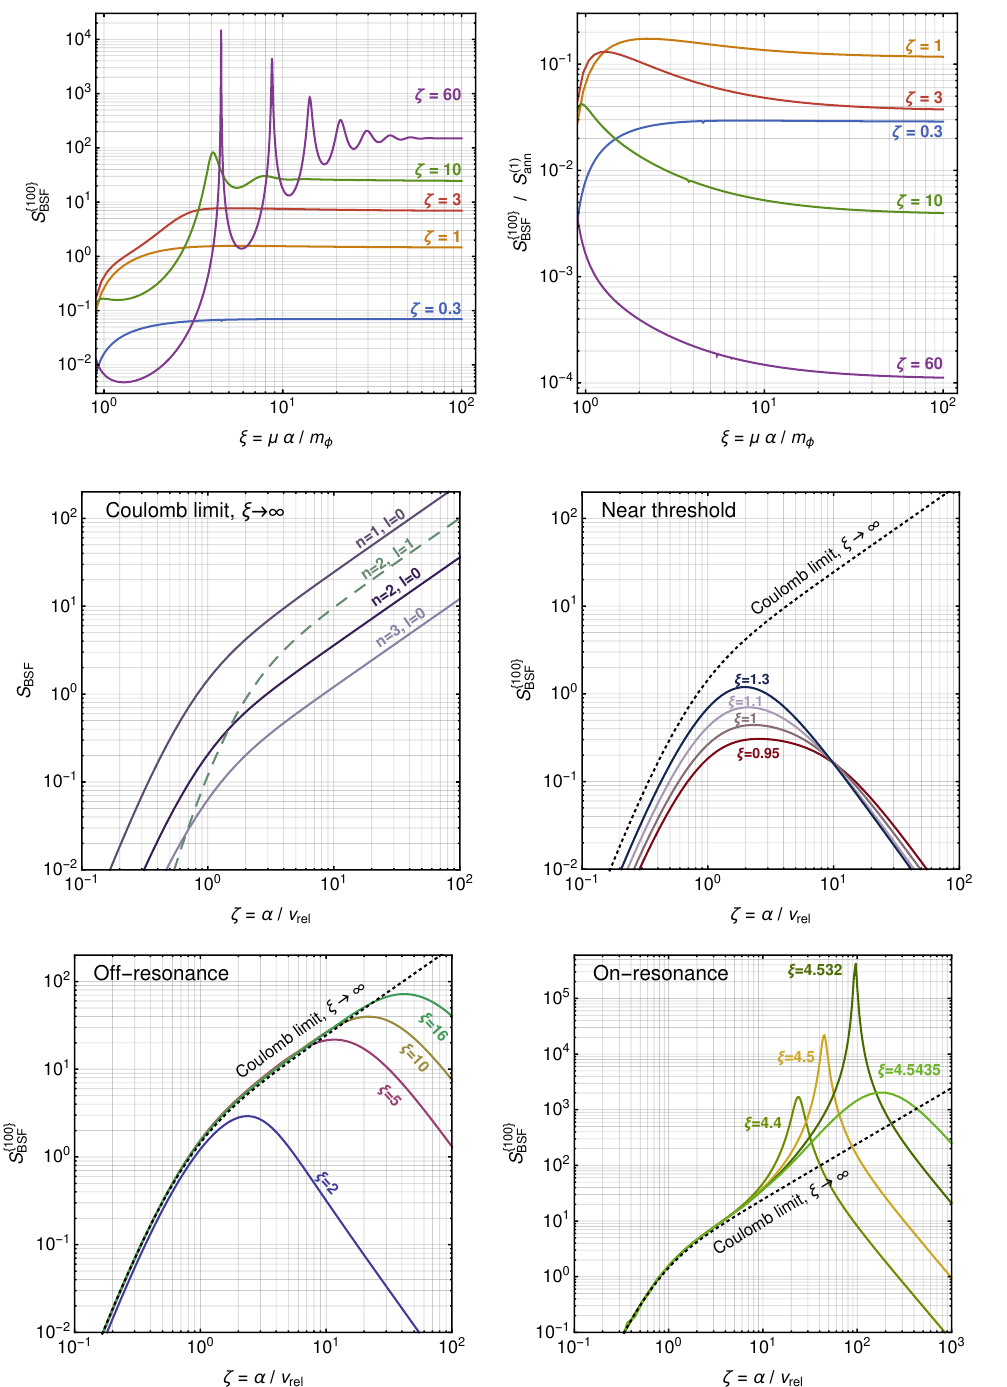
Figure 7 . Resonance structure (upper two panels) and velocity dependence (lower four panels) of the S factors determining the cross-sections for the formation of bound states with emission BSF of a scalar force mediator, by two particles with di(cid:11)erent masses and/or couplings [cf. eqs. (4.5) and